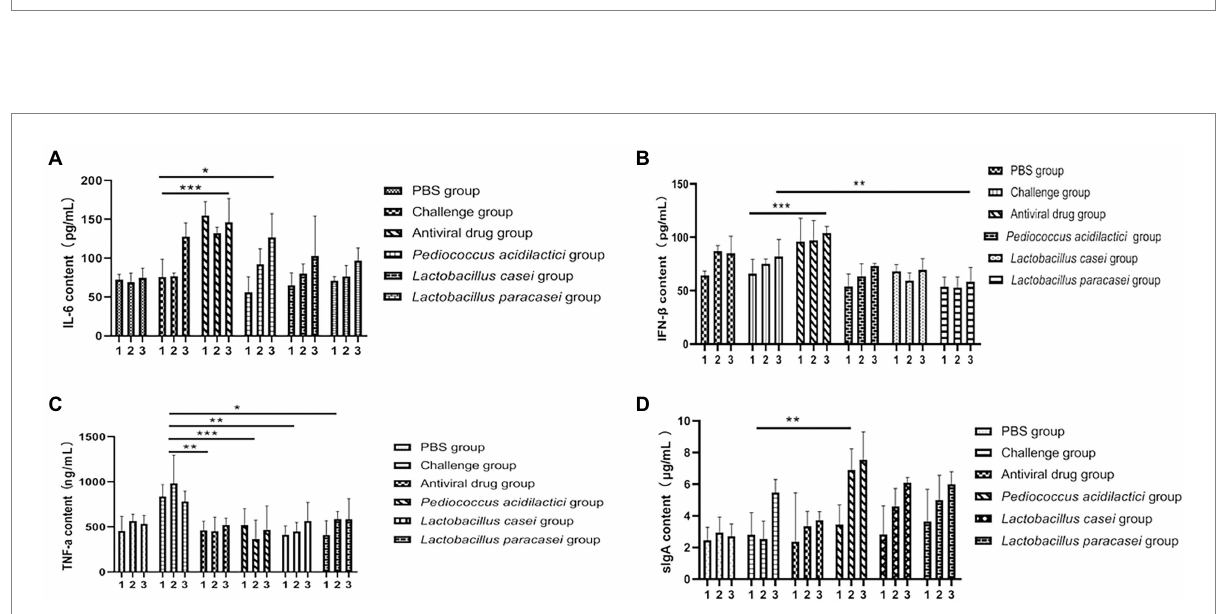
FIGURE 5 Cytokines and secretory sIgA in the blood of mice were detected by ELISA. (A) The change in IFN- β concentration in the blood of mice in three time periods. (B) The change of the concentration of IL-6 in the three stages. (C) The change in TNF- α concentration in the three